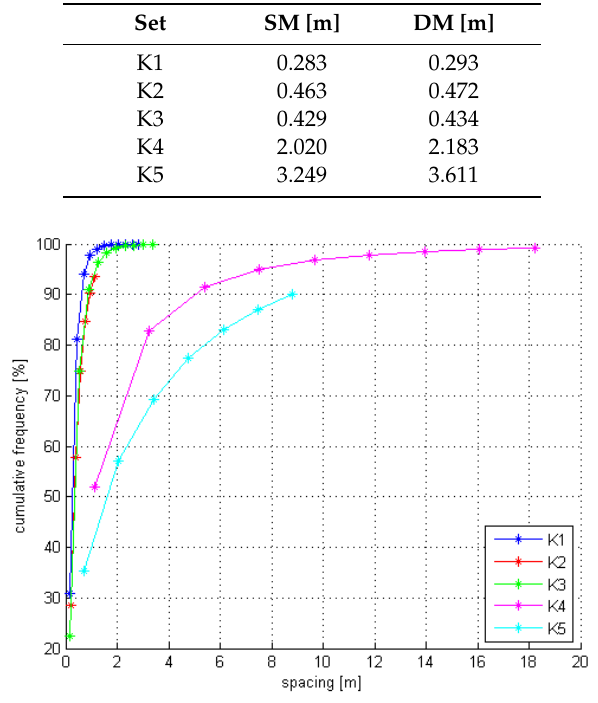
Figure 7. Spacing cumulative distribution function (CDF) obtained for each of the main discontinuity sets.